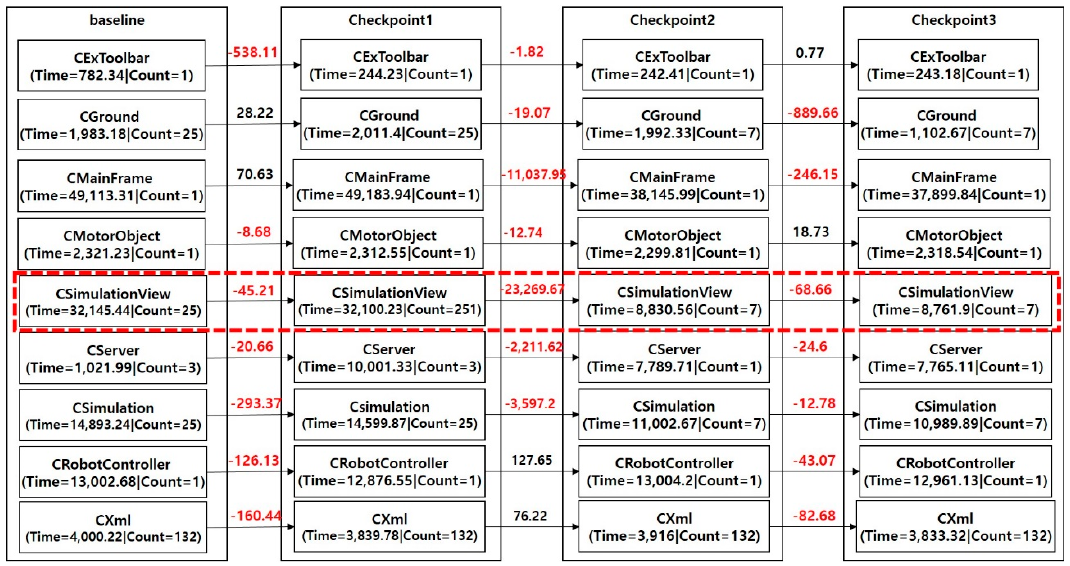
Figure 7 . Results of the measurement of the multiple-joint robot simulator’s performance .